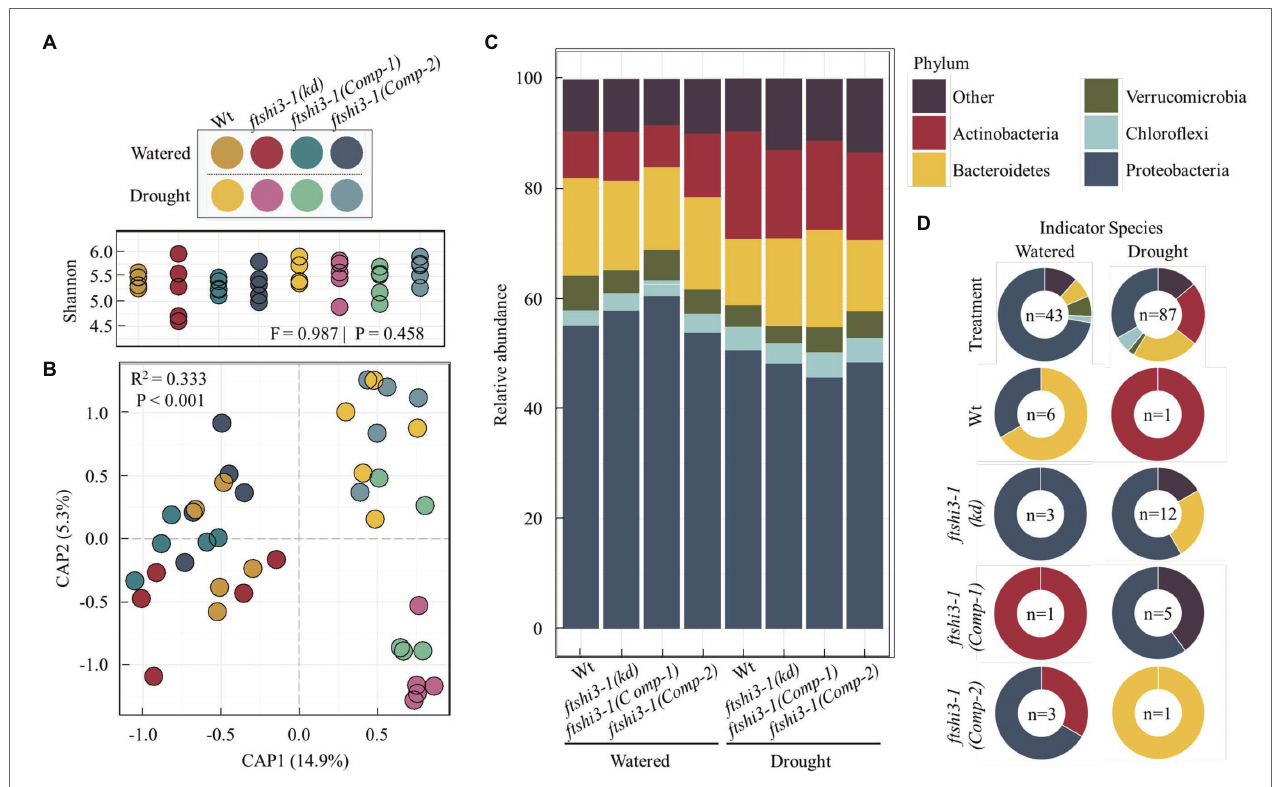
FIGURE 7 | The root-associated bacteria of ftshi3-1(kd) shift under drought. (A) Alpha diversity (Shannon) of root-associated bacteria. Colors depict different watering treatments and host genotypes. (B) Constrained ordination of root-associated bacterial community composition constrained the interaction between treatment and genotype and colored as in (A) . (C) The relative abundance of root bacteria at the phylum level. Colors represent the top five phyla. Additional phyla combined as “Other.” (D) Significant bacterial indicators of watering or drought treatment across all genotypes (top two plots) or between all genotypes and treatments (bottom eight plots) identified by Dufrene-Legendre analysis ( p < 0.05, indcls > 0.5). The number of significant indicators identified for each group is listed in the center of each chart. Indicators were merged by phyla, with colors representing the top five phyla as in (C)